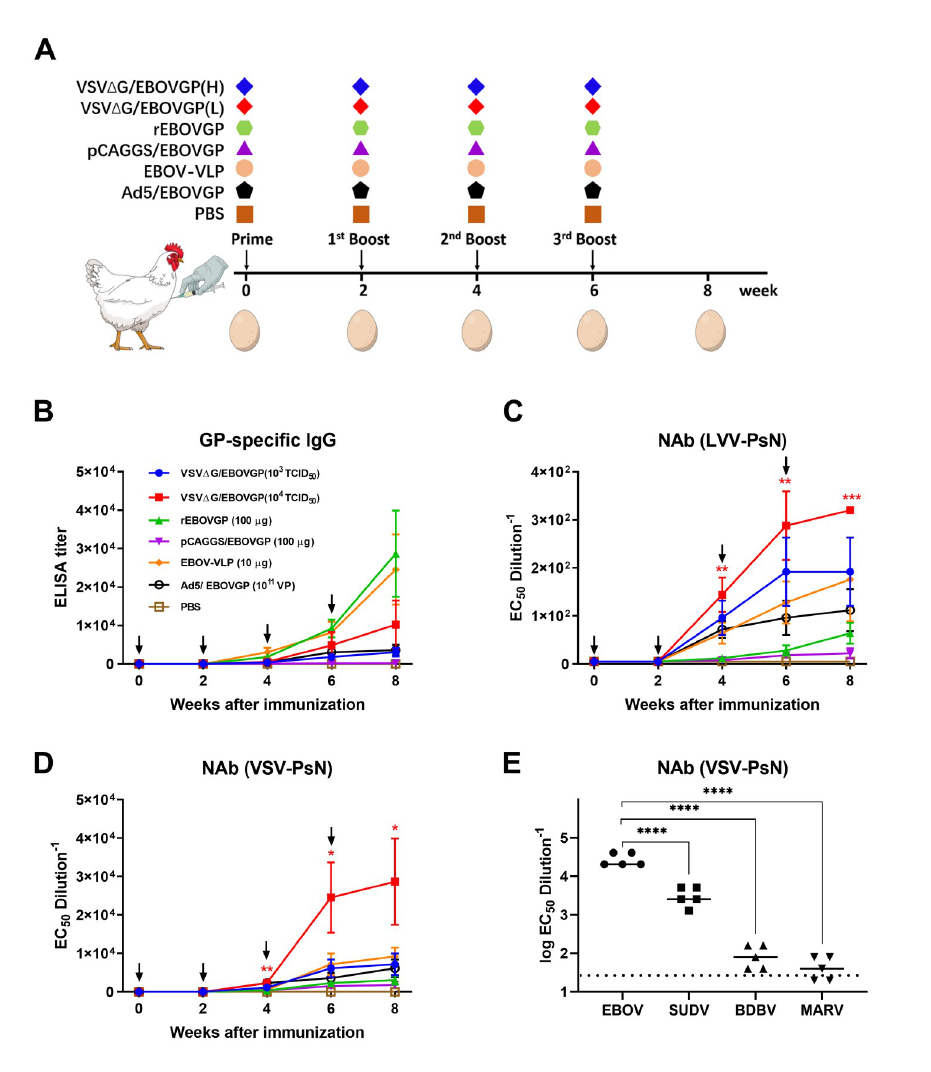
Fig 2. Immunogenicity of different EBOV vaccine candidates in laying hens. (A) Seven groups of laying hens (5-month-old, n = 5 per group) were inoculated with VSV Δ G/EBOVGP, rEBOVGP, pCAGGS/EBOVGP, EBOV-VLP, Ad5/EBOVGP or PBS as control, respectively, through i.m. route at 0, 2, 4, 6 weeks. The eggs were collected at 0, 2, 4, 6, 8 weeks respectively. The yolk IgY were purified and used to test the GP-specific ELISA antibody titers (B) and NAb titers (C, D) by LVV-PsN and VSV-PsN assay. A two-way analysis of variance (ANOVA) with Tukey’s multiple- comparison tests was performed to statistically analyse significant differences among different immunogen groups. Significant differences were observed between VSV Δ G/EBOVGP and PBS at 4, 6, and 8 weeks post immunisation. The NAb titers of IgY antibodies collected at week 8 against EBOV, SUDV, BDBV and MARV were evaluated using VSV-PsN respectively (E). A one-way ANOVA test was performed to indicate statistical significance among different NAb test groups. The black arrows in b, c and d represent the immunisation time point. The dashed line in e indicates the detection limit. Data are shown as means ± SEM. In all panels with P values: � P < 0.05; �� P < 0.01; ��� P < 0.001; ���� P <